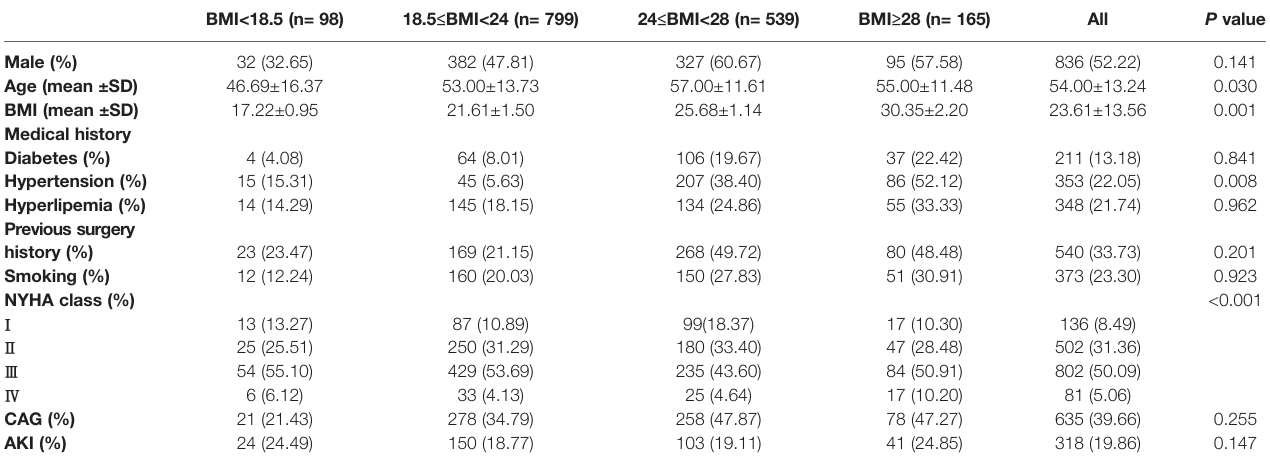
TABLE 3 | Subgroup analysis of clinical characteristics according to